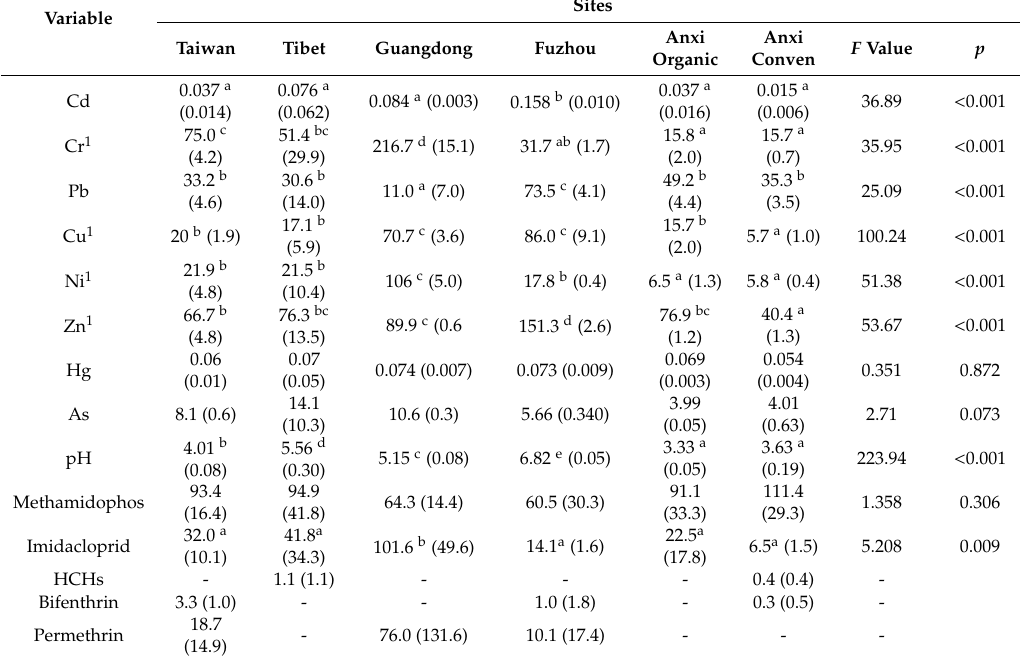
Table 2. Descriptive statistics (means ± (sd)) of pH, heavy metals (mg / kg) and pesticide residue contents ( µ g / kg) in soil samples ( n = 3 samples / sites). Significant di ff erences among sites (within a row) are marked by letters in superscripts according to Duncan’s LSD multiple range test following a one-way analysis of variance (Bonferroni, p ≤ 0.006). Note that statistical analyses were not performed for HCHs, Imidacloprid and Permethrin due to undetectable values in many